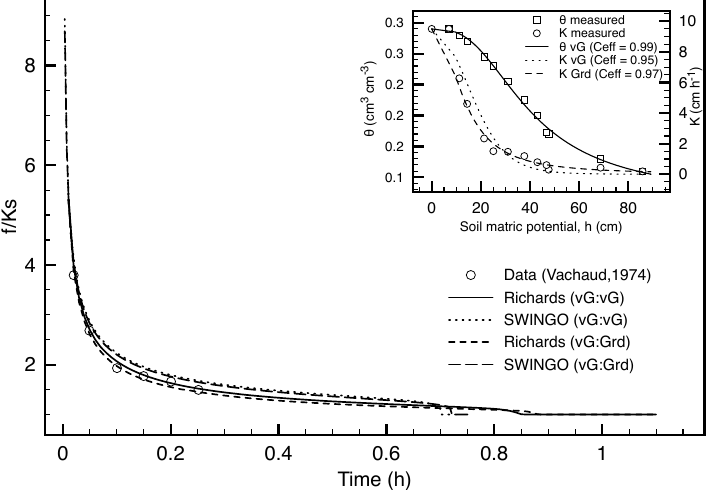
Figure 6. Comparison of the simplified and RE results against Vachaud et al. (1974) experimental data set (figure body), and fitting of soil water characteristics to different equations (inset); vG and Grd represent, respectively, the van Genuchten and Gardner’s soil characteristic curves used to parametrize the simplified and RE models (see Table 1 for details).